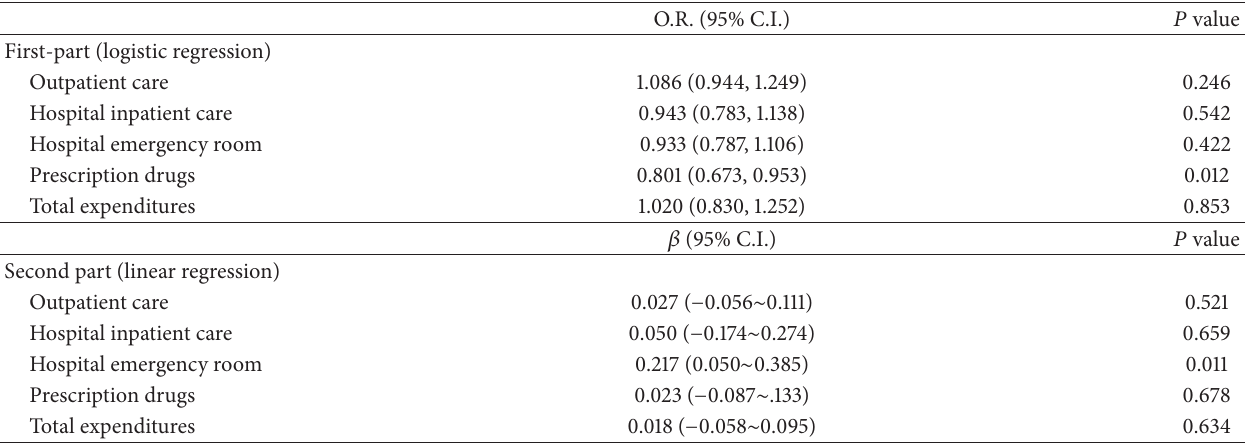
Table 3: Two-part model estimated of impact of urban (versus rural) residency, weighted data adjusted for personal characteristics covariates, MEPS 2010.